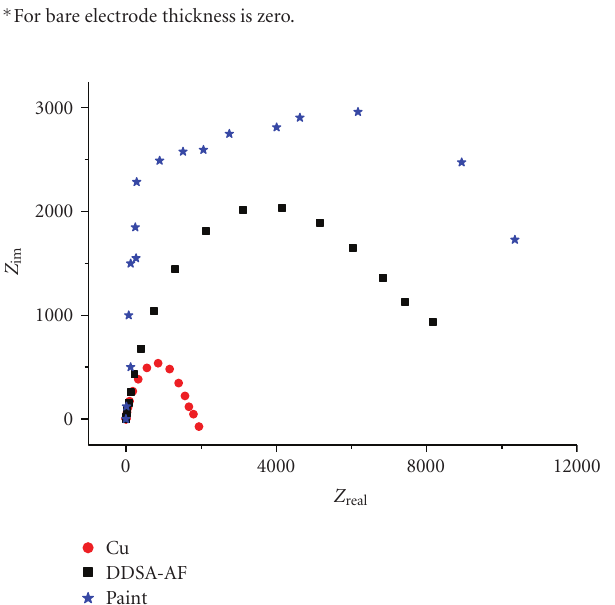
Figure 5: Nyquist diagramsfor bare, resin, and paint coated copper. as even paints contain some additives that increase their resistance and performance (Figure 5).